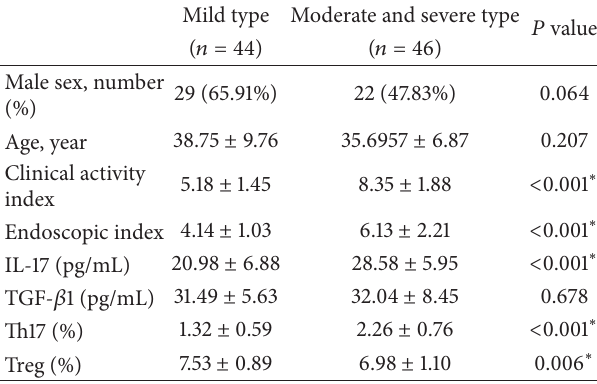
Table 2: Demographic details and clinical characteristics in mild type and moderate and severe type of UC